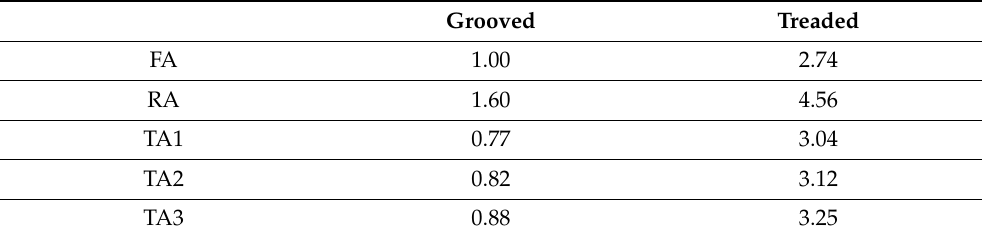
Table 3. Normalized ventilation drag F Vent , i / F Vent , FA , Grooved of the different wheel configurations at the front axle (FA), the rear axle (RA), and the trailer axle (TA).